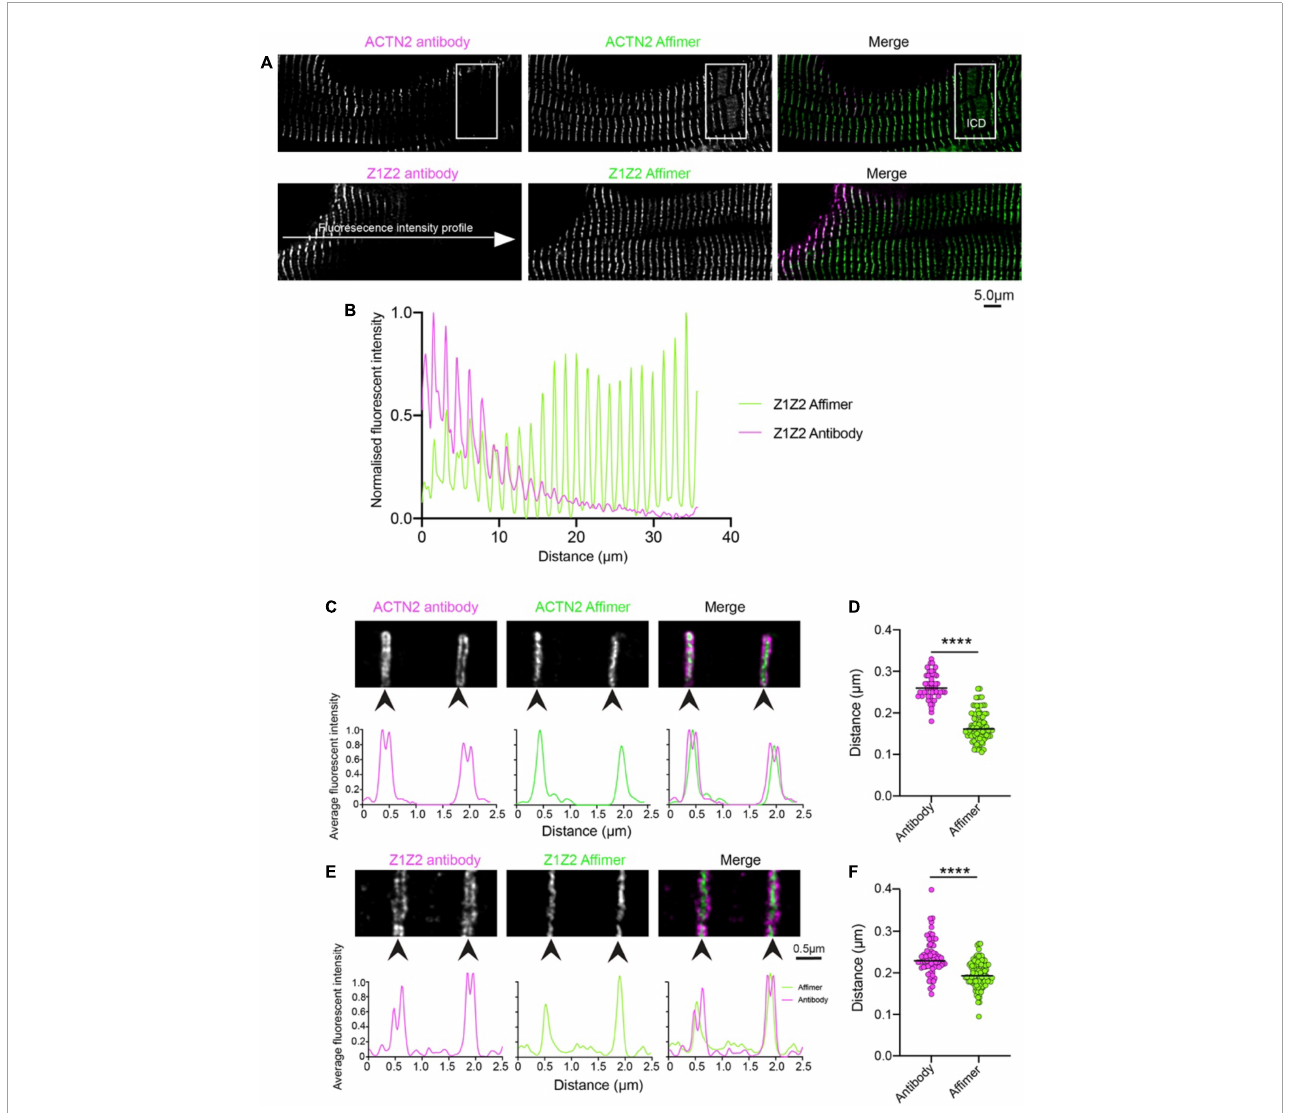
FIGURE1 Comparison of staining heart sections using antibodies and Affimers to ACTN2 and titin Z1Z2 repeats. (A) Example confocal image of a region of a donor heart section stained using a primary antibody to ACTN2 or the Z1Z2 repeat of titin combined with a secondary fluorescent antibody, and with a dye-labelled Affimer. The boxed region shows the position of the ICD: intercalated disc. (B) Example of fluorescence intensity (normalized) for a line profile drawn across the cell for the ACTN2 antibody (magenta) and Affimer (green). Example 2D-STED images for Z-discs stained using the ACTN2 primary and secondary antibody combination and the dye-labelled ACTN2 Affimer (C) and the titin Z1Z2 antibody combination and Z1Z2 Affimer (E) are shown together with the associated profile plots for the labelling intensity across the Z-disc structures. (D,F) Measurements of the Z-disc widths for multiple Z-discs from sections labelled with the antibody combination and Affimers, using either the antibody images or the Affimer images. **** p < 0.0001.